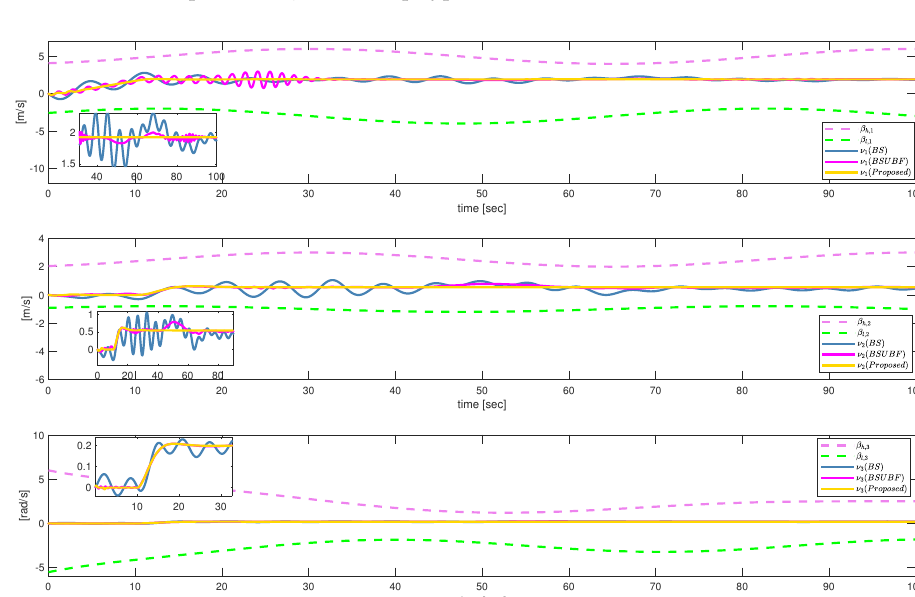
Figure 6. Time responses of ν under step-type